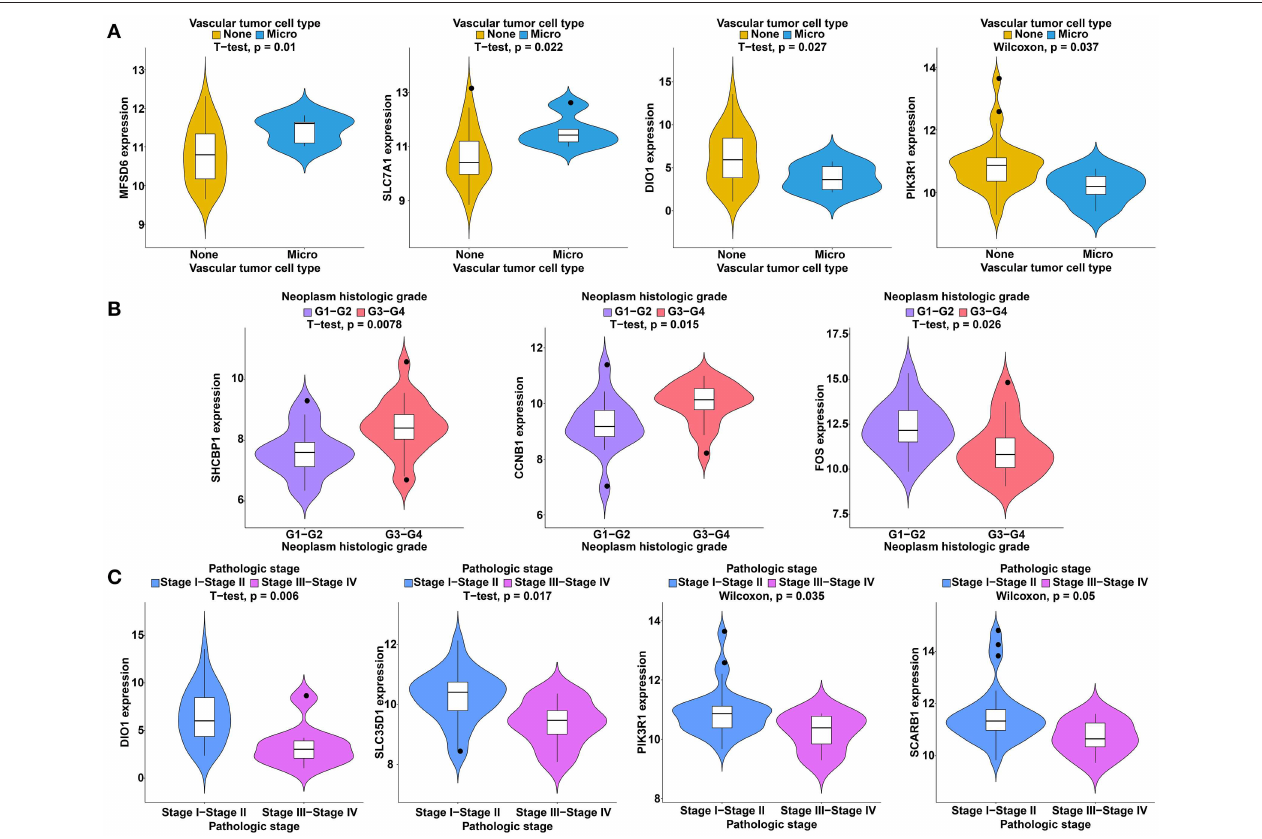
FIGURE 10 | Clinical feature analysis of DEmRNAs in the ceRNA network. The correlation between DEmRNAs involved in the ceRNA network and vascular invasion (A) , neoplasm histologic grade (B) and pathologic stage (C) .